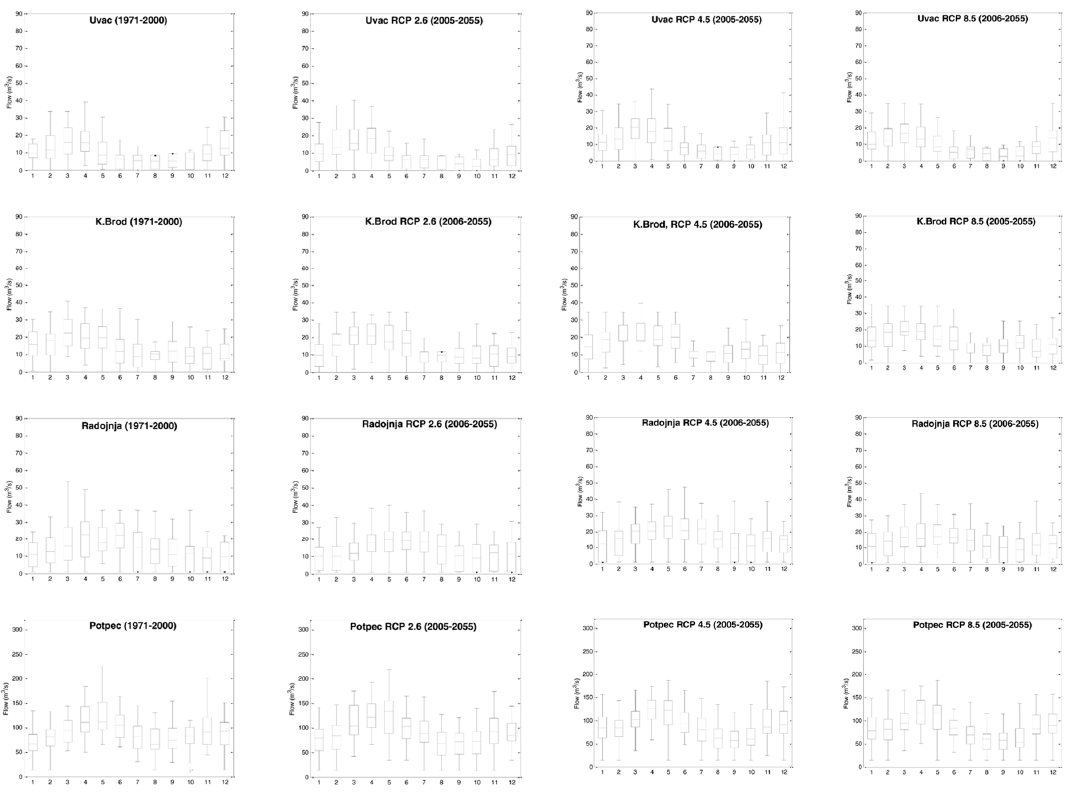
Figure 10. Box plots of the monthly outflows from the Lim water system reservoirs (Uvac, Kokin Brod, Radojnja and Potpec).